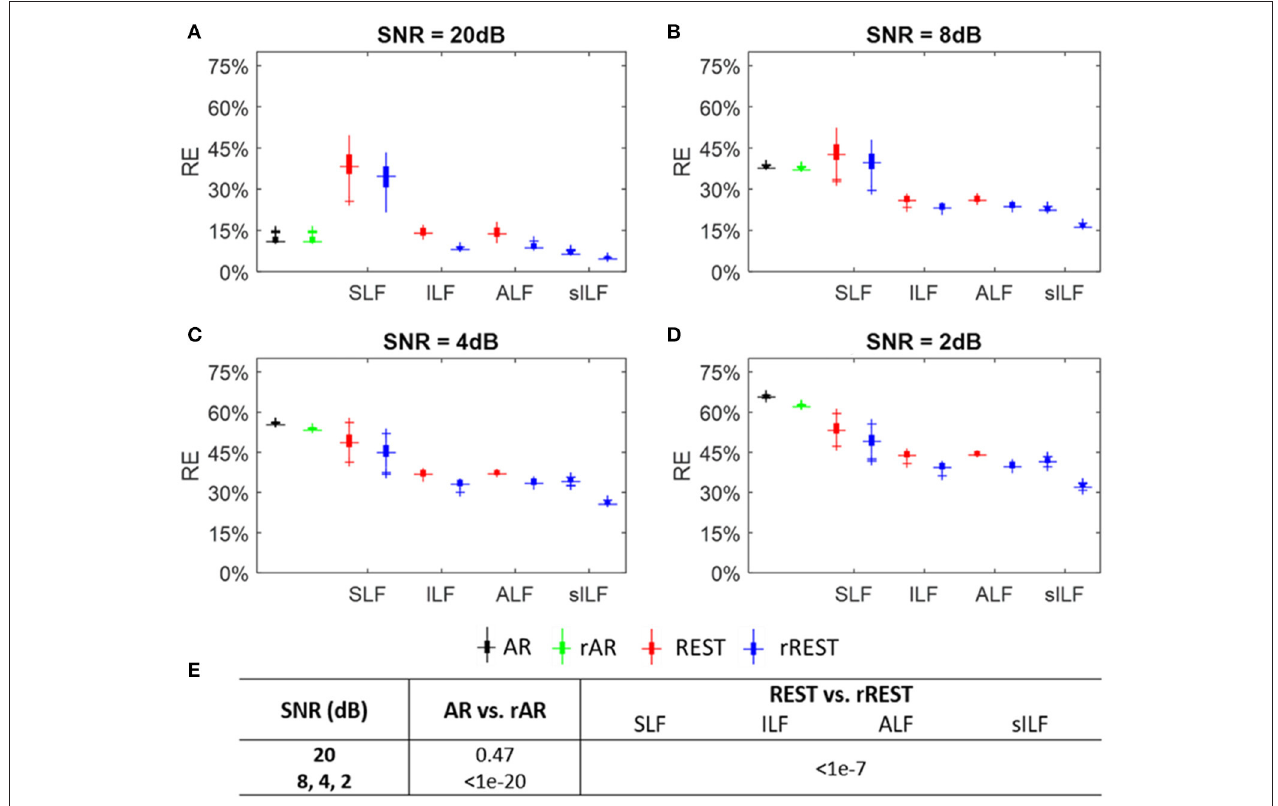
FIGURE 4 | Relative error (RE) of reference estimators. (A–D) The boxplots of REs with SNR = 20, 8, 4, and 2 dB, respectively. Volume conduction model tested for REST and rREST are spherical lead field (SLF), individual lead field (ILF), average lead field (ALF), and sparse individual lead field (sILF). (E) The p -values of REs between ordinary references (AR, REST) and regularized references (rAR, rREST) under different SNR and various lead fields,